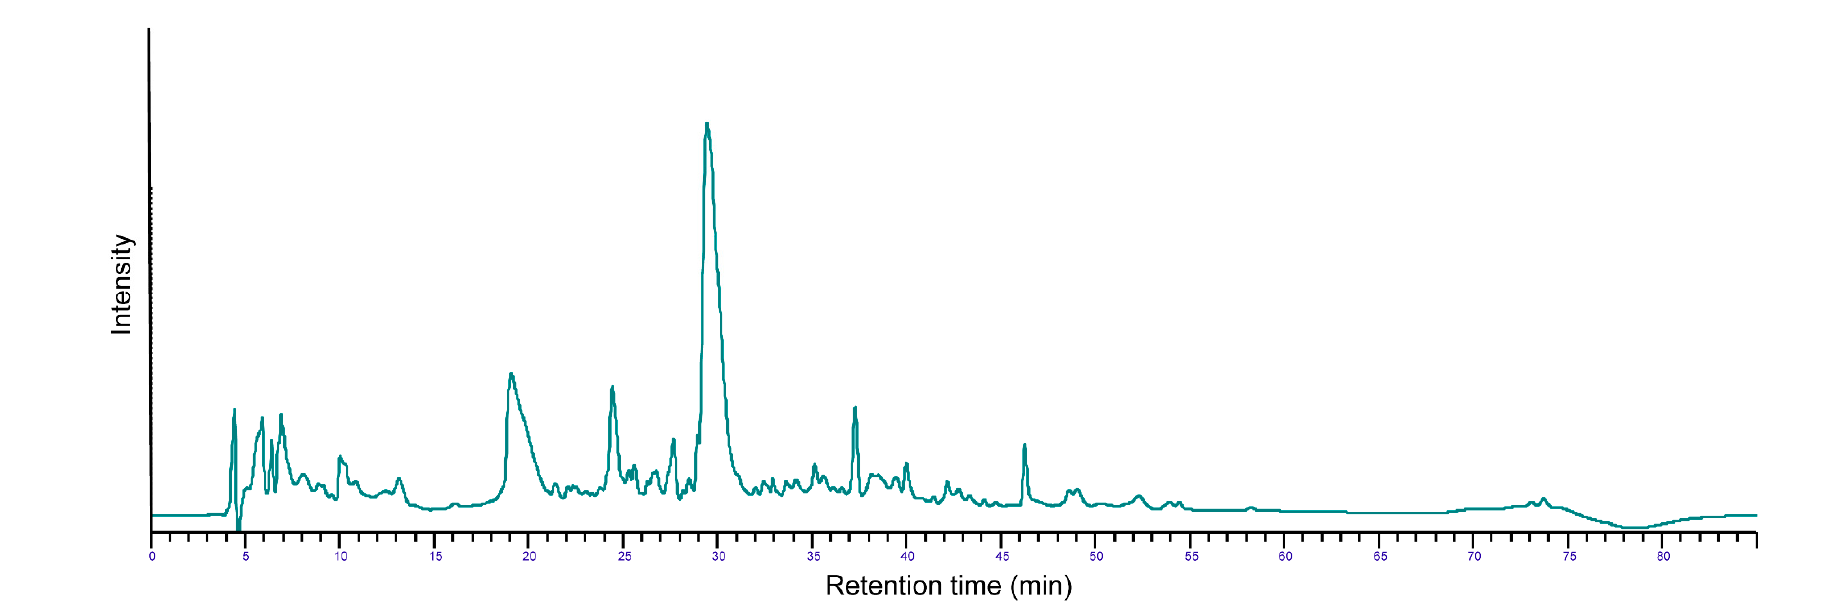
Figure 1. RP-HPLC chromatogram of the extensively hydrolyzed casein displaying its peptide